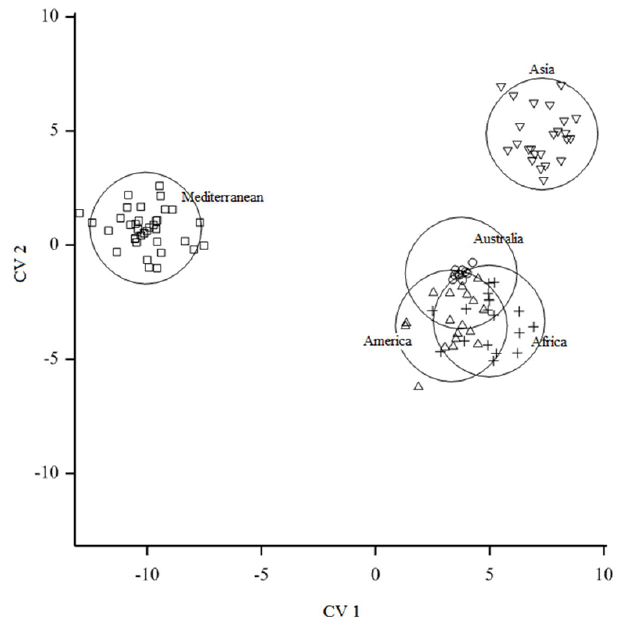
Figure 3. Canonical variates of climatic niches of Leptocybe spp. collection locations grouped as populations. Circles represent 95% confidence regions of the groups assuming normal distribution of data.